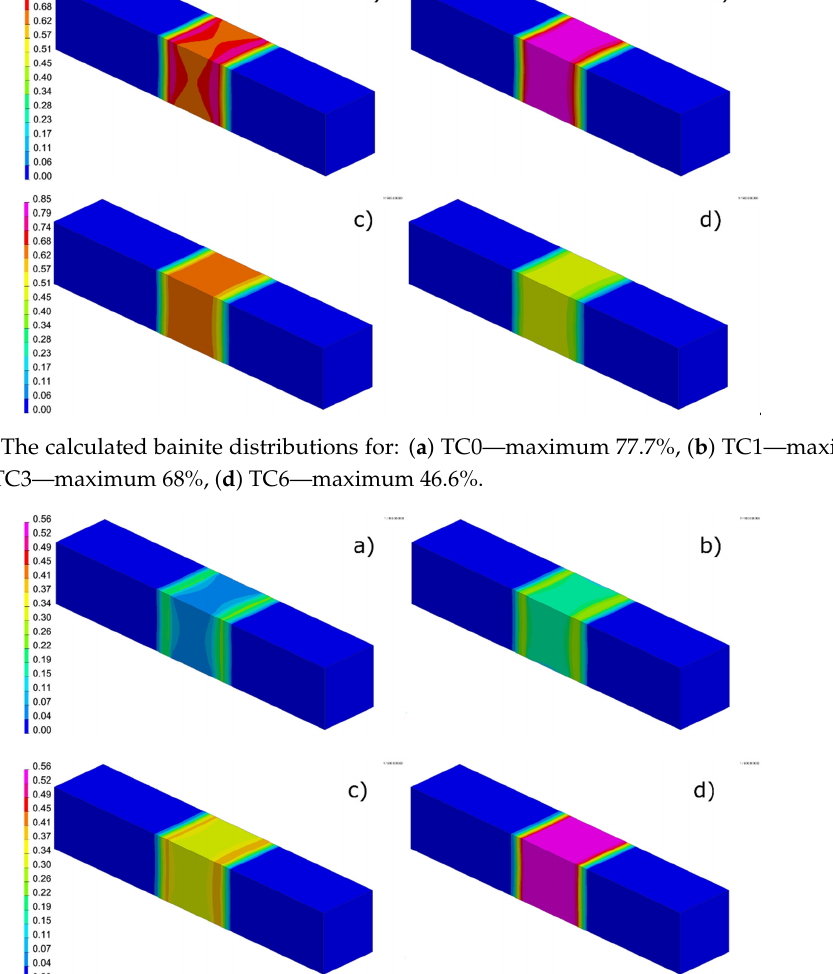
Figure 17. The calculated ferrite distributions for: ( a ) TC0—maximum 31%, ( b ) TC1—maximum 35.4%, ( c ) TC3—maximum 44.2%, ( d ) TC6—maximum 56.3%.